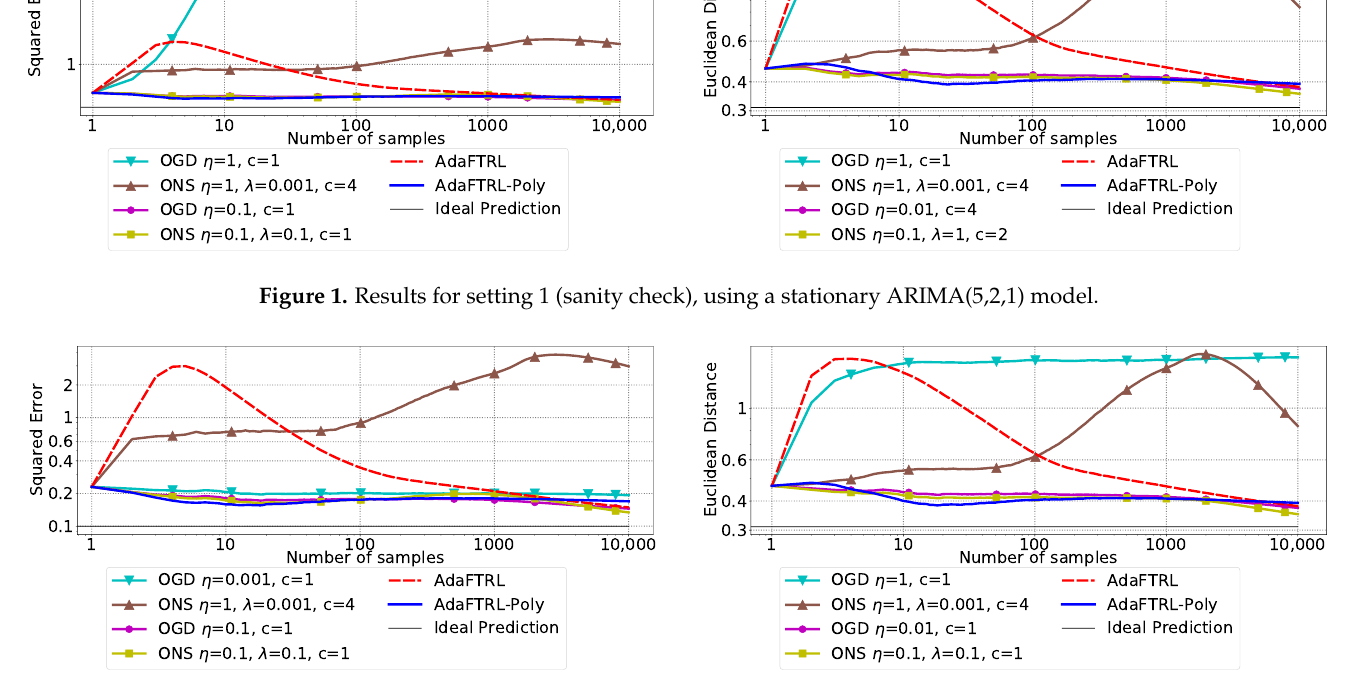
Figure 2. Results for setting 2 (time-varying parameters), using a non-stationary ARIMA(5,2,1) model.